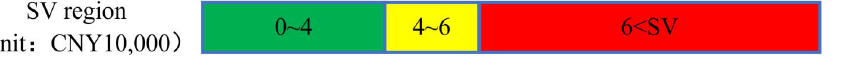
Figure 7. Risk map.